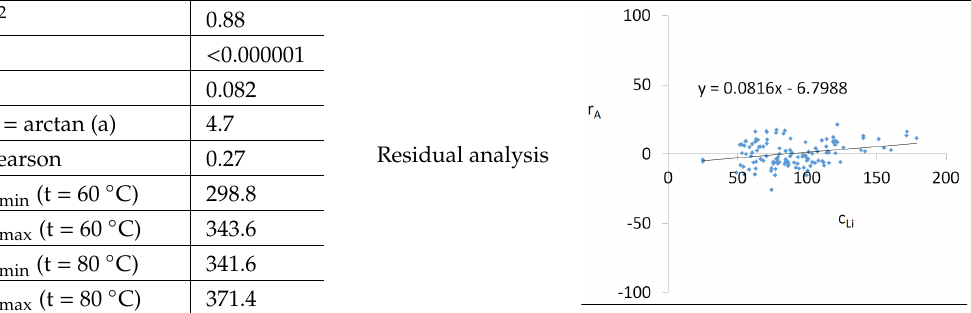
Table 5; CS Li , CS Si , CS Sr , CS Ca –Li, Si, Sr, Ca concentrations in shale sample before